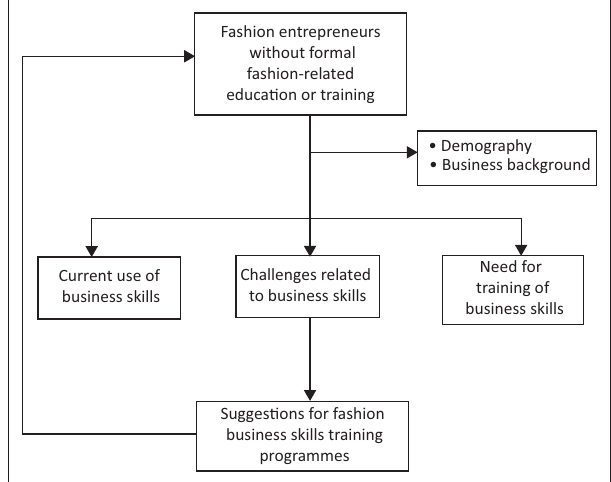
FIGURE 1: Conceptual